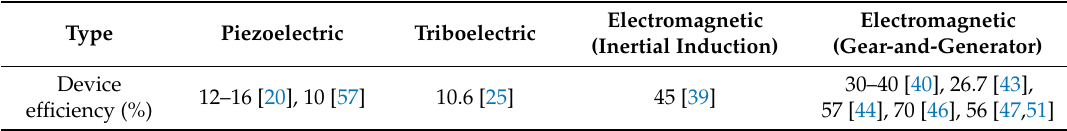
Table 6. Device efficiency of wearable energy